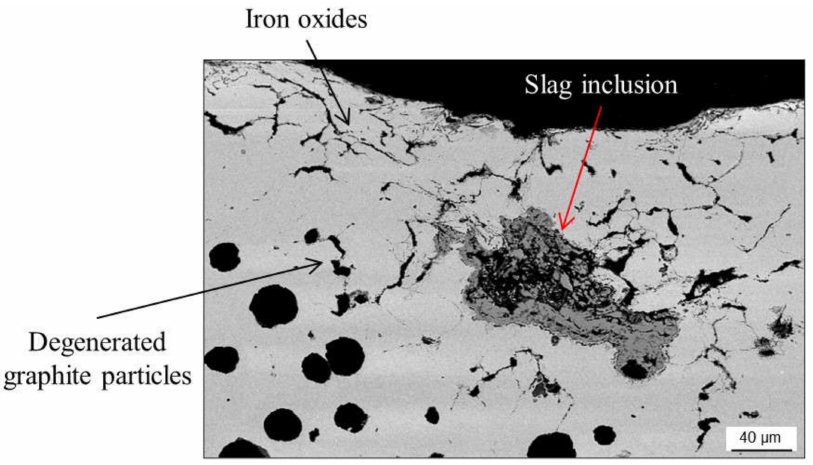
Figure 34. Metallographic cross section of a slag inclusion in a ductile iron